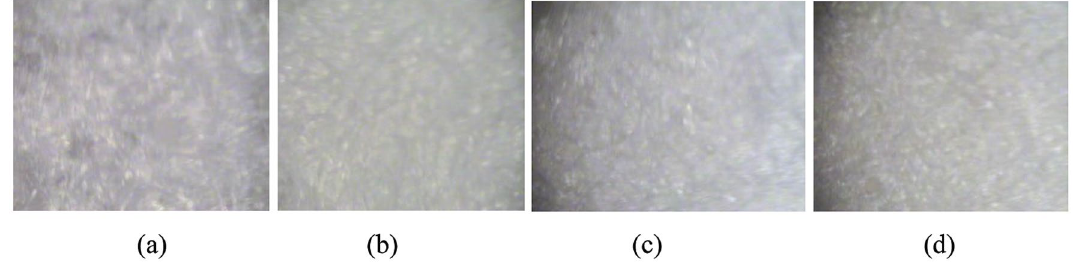
Figure 3. Images of ( a ) simulate blood sample ( b ) Oyster (NIST 1566B) CRM ( c ) healthy blood sample and ( d ) Plasmodium falciparum -infected blood sample (10X).